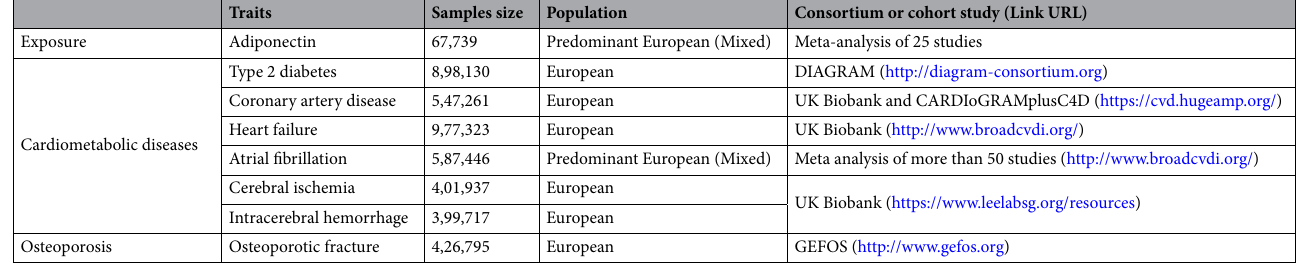
Table 1. Details of studies and datasets used for